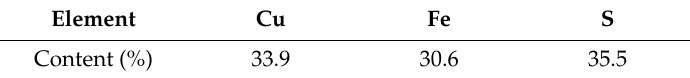
Figure 1. X-ray diffractogram of chalcopyrite ore. Figure 1. X-ray di ff ractogram of chalcopyrite ore. Table 1. Chemical analysis of the Table 1. Chemical analysis of the sample.